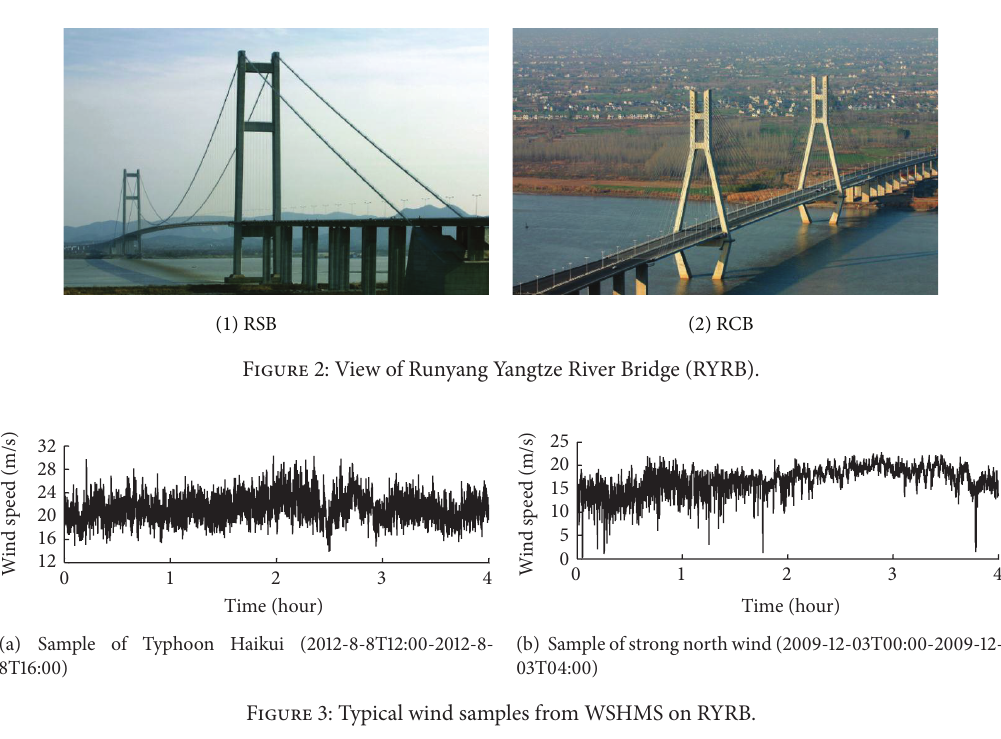
Figure 3: Typical wind samples from WSHMS on RYRB.